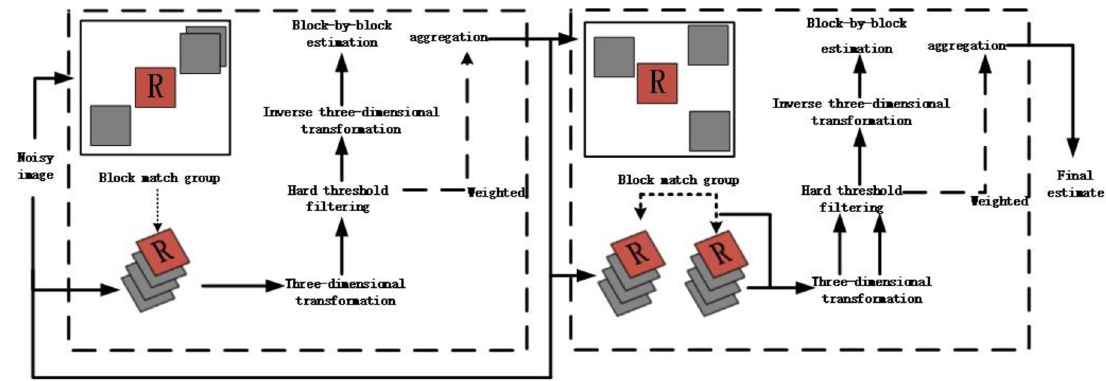
Fig 1. BM3D image denoising flow chart.